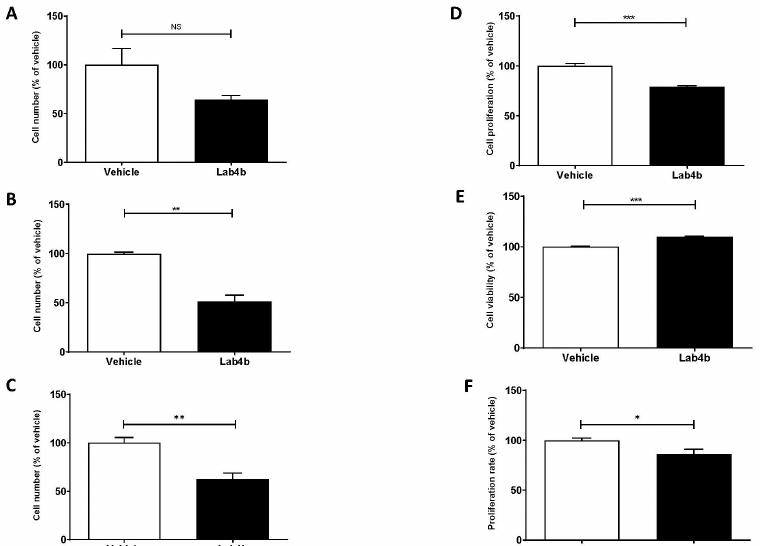
Figure 5. Lab4b CM attenuates proliferation of human monocytes and macrophages. ( A – C ), THP-1 monocytes were treated with either vehicle or 1.5 μ g/mL Lab4b CM and cell numbers counted at days 2, 5, and 7 and represented to the vehicle control, which was arbitrarily assigned as 100%. ( D ), THP-1 macrophages were treated for 48 h with vehicle or 1.5 μ g/mL Lab4b CM and change in proliferation, as assessed by the crystal violet assay, was determined as a percentage relative to the vehicle control, which was arbitrarily assigned as 100%. ( E ), The supernatant from the same cells was used to assess viability via LDH activity and determined as a percentage of the vehicle control, which was arbitrarily assigned as 100%. ( F ), The proliferation rate of THP-1 macrophages was determined by following BrdU incorporation following treatment of THP-1 macrophages with vehicle or 1.5 µ g/mL Lab4b CM. Proliferation rate was determined as a percentage of vehicle, which was assigned as 100%. Data are mean ± SEM from three independent experiments, and statistical analysis was carried out using an unpaired Student’s t -test (*, p ≤ 0.05; **, p ≤ 0.01; ***, p ≤ 0.001; NS, not significant).